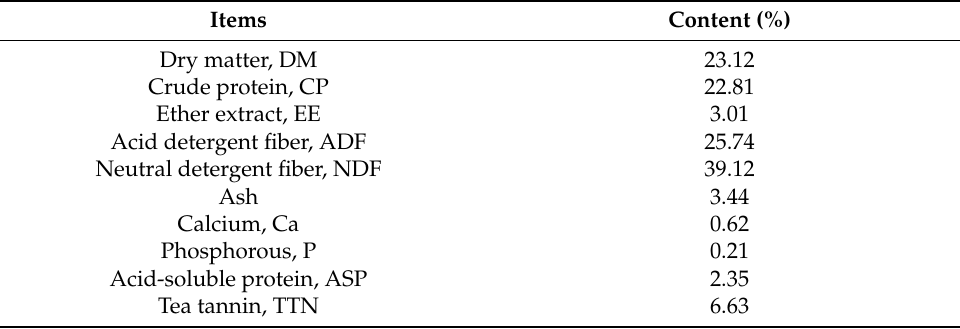
Table 1. Chemical composition of tea residue (% dry